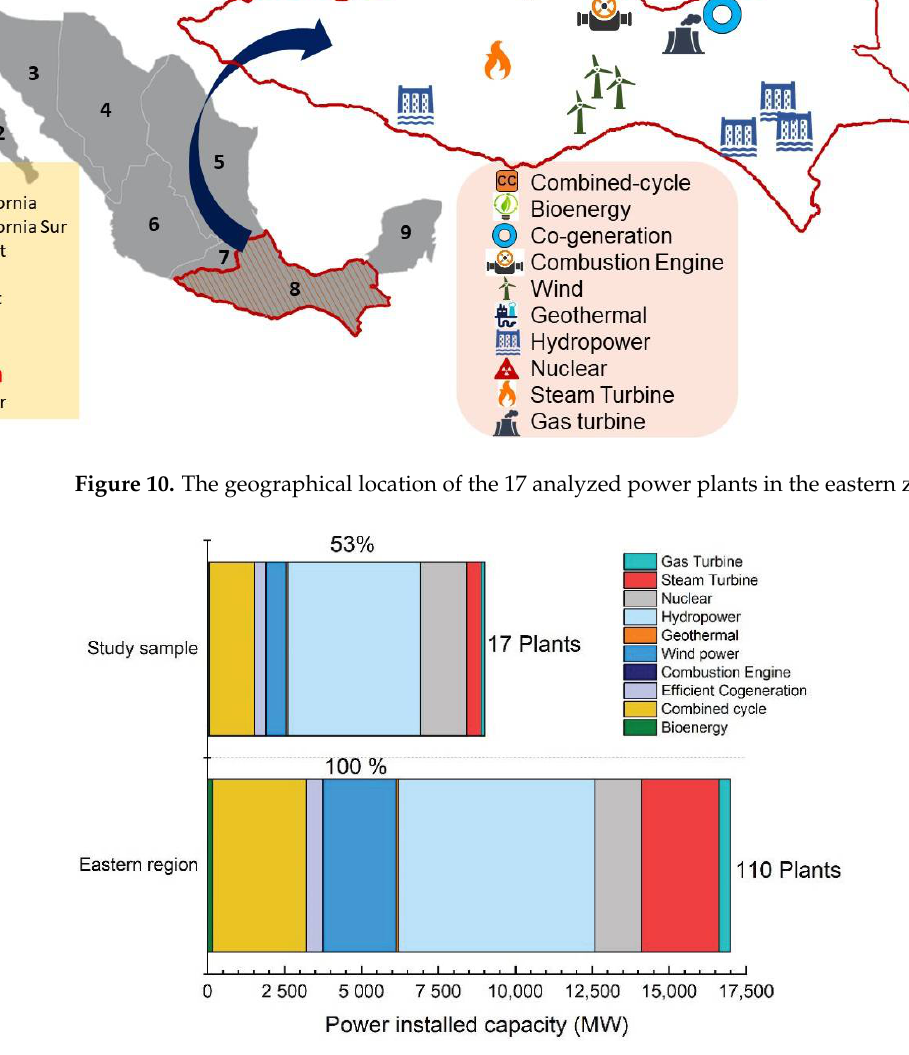
Figure 12. Variation of demand as a function of time of day and required consumption by period for the four days of each season.